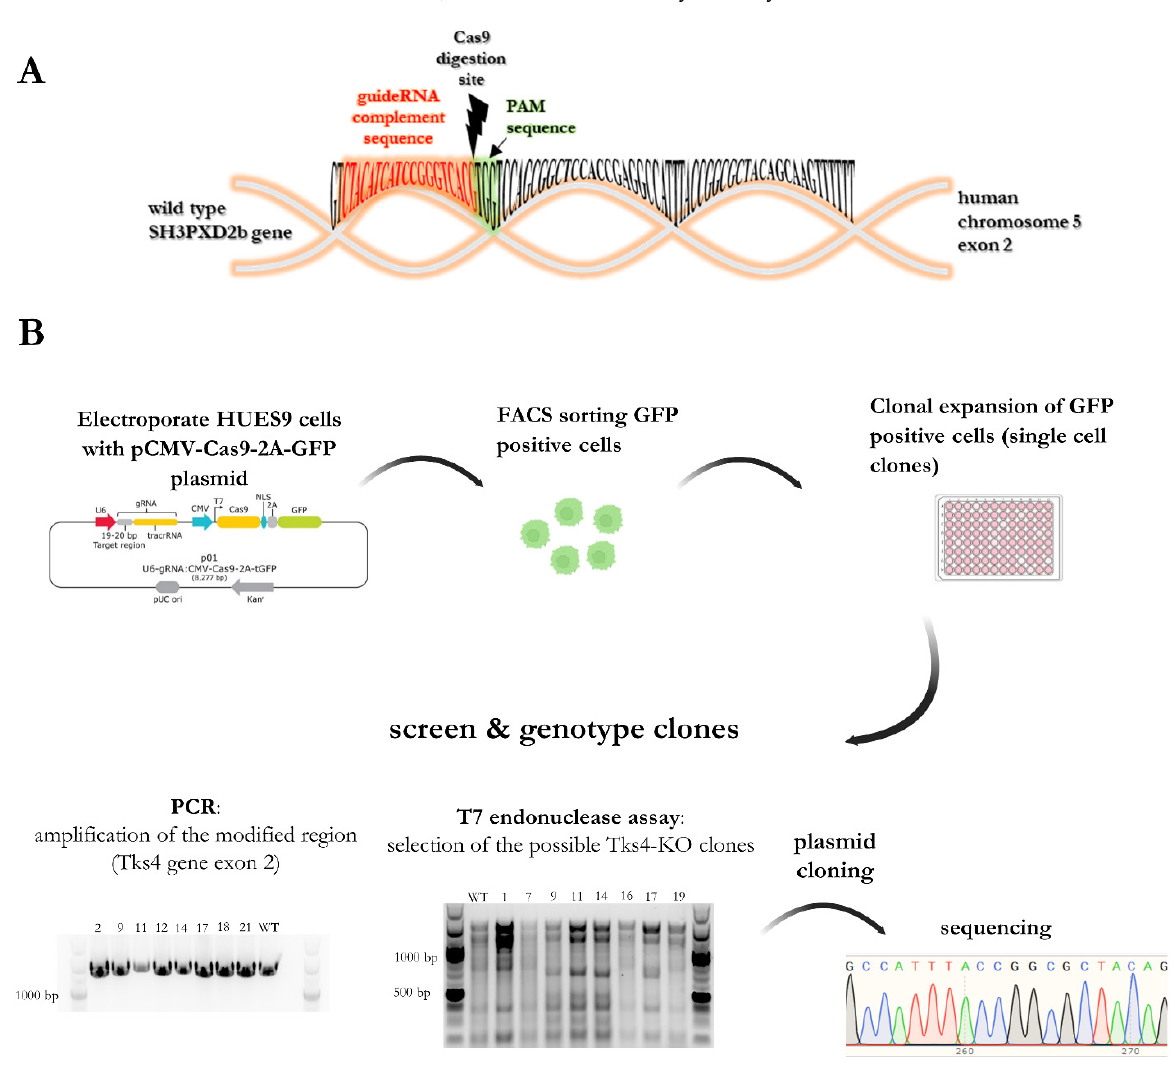
Figure 4. ( A ) A schematic overview of the mutant region of SH3PXD2b exon 2 on human chromosome 5, showing the complementary sequence of the guide RNA (gRNA), the Cas9 digestion site, and the PAM sequence; ( B ) Stepwise representation of the knock-out generation and clonal screening strategy for Tks4-KO HUES9 cells after genome editing. After single-cell plating of GFP+ cells, 21 clones were expanded for genomic DNA isolation and T7 endonuclease analysis. Next, 10 DNA samples from potentially mutated clones were used for amplification of the affected region of exon 2 and cloned in plasmid. Sanger sequencing confirmed the isolation of two homozygous Tks4-KO clones and two heterozygous Tks4 clones. Secondary antibodies were: Goat-Anti-Mouse antibody /(H + L), Alexa Fluor